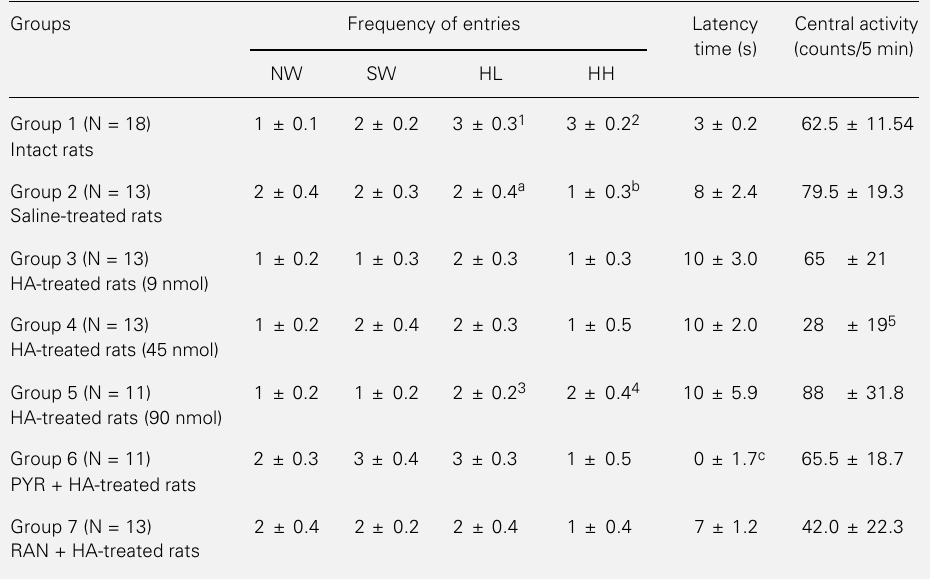
Table 1 - Behavioral parameters measured in the asymmetric plus-maze of intact and implanted rats subjected to different treatments. a P<0.01 vs intact rats; b P<0.01 vs intact rats; c P<0.01 vs HA 9, HA 45 and HA 90 groups. 1 P<0.01 vs NW (same group); 2 P<0.05 vs NW (same group); 3 P<0.05 vs NW and SW (same group); 4 P<0.05 vs NW and SW (same group); 5 P<0.05, group 4 vs group 5. See Figure 1 for explanation of